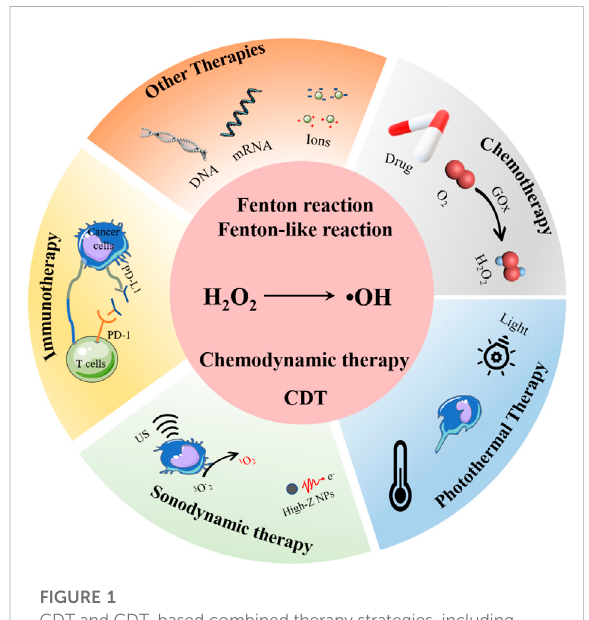
FIGURE 1 CDT and CDT-based combined therapy strategies, including combination with chemotherapy, photothermal therapy, sonodynamic therapy, and